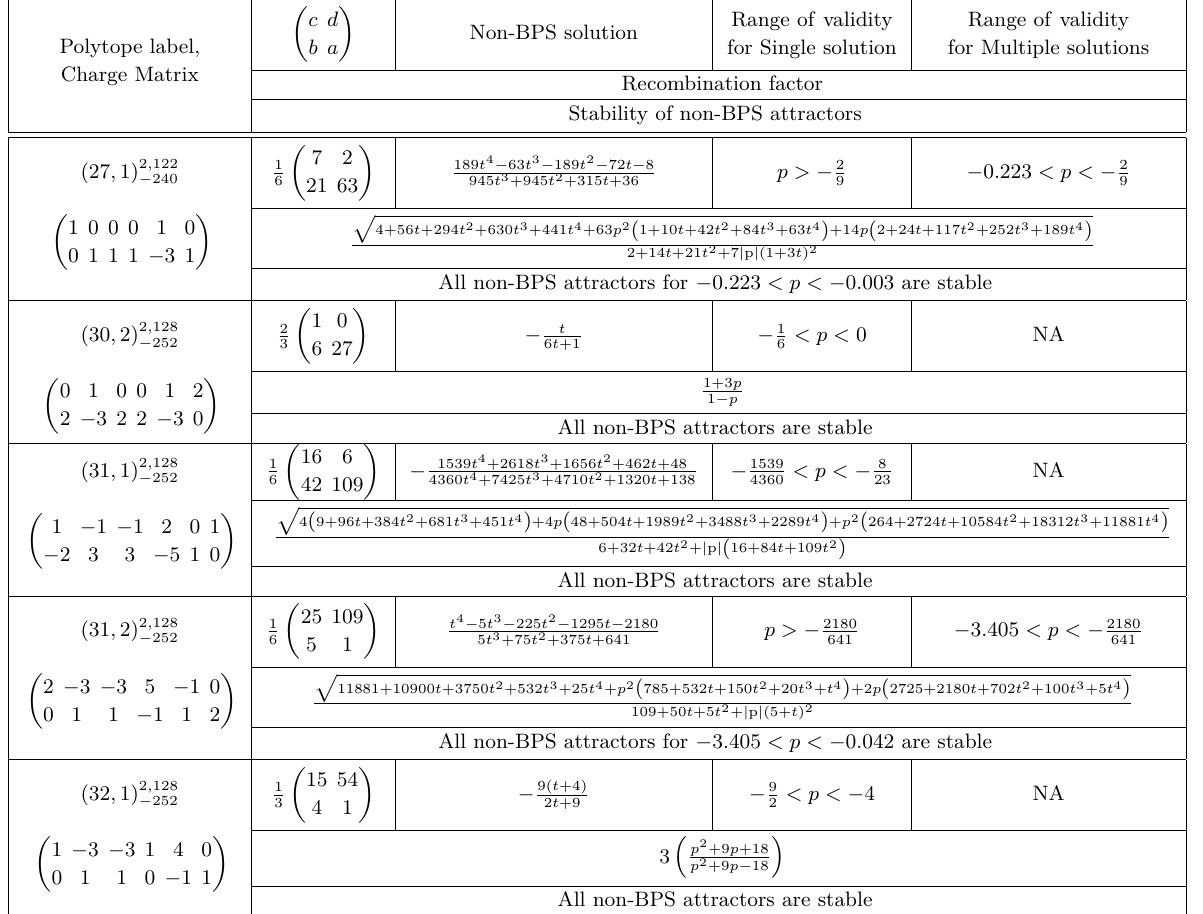
Table 17 . Non-BPS extremal (multiple) black strings in one-modulus THCY models,